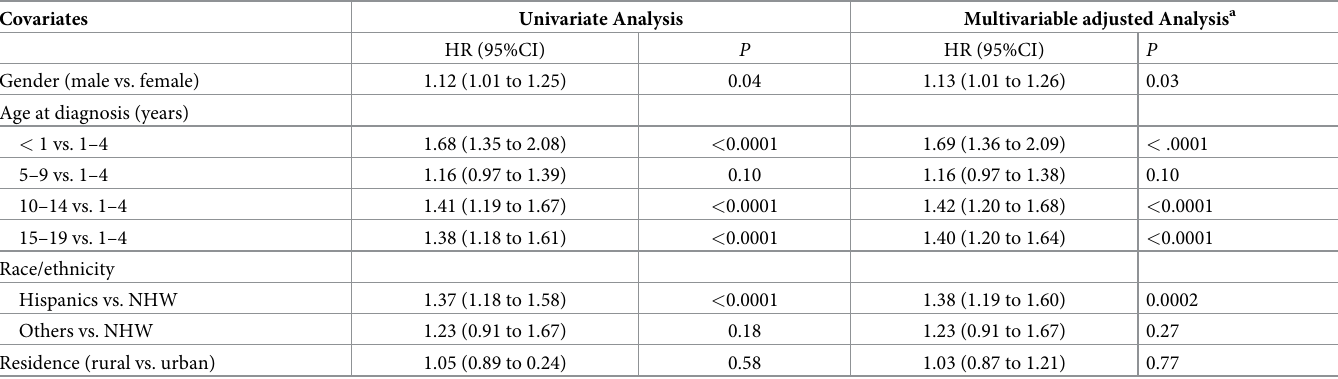
Table 3. Cox proportional survival analyses of South Texas childhood cancer